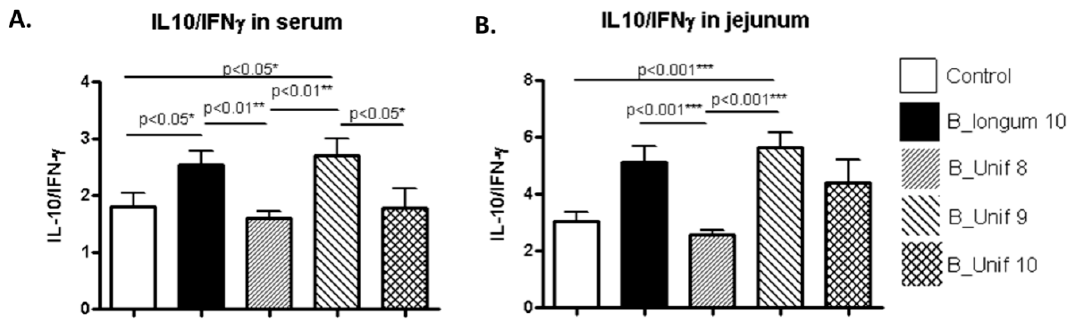
Figure 5. IL-10 / IFN- γ ratios in serum and jejunum samples from the experimental animal groups. ( A ) IL-10 / IFN- γ ratios (pg / mL) in serum samples at the end of the study for all groups (50 animals, n = 10 per group). ( B ) IL-10 / IFN- γ ratios (pg / mL) in jejunum samples at the end of the study for all groups (50 animals, n = 10 per group). Measurements were made in duplicate. Statistical significance was considered when p < 0.050. * p ≤ 0.05, ** p ≤ 0.01.